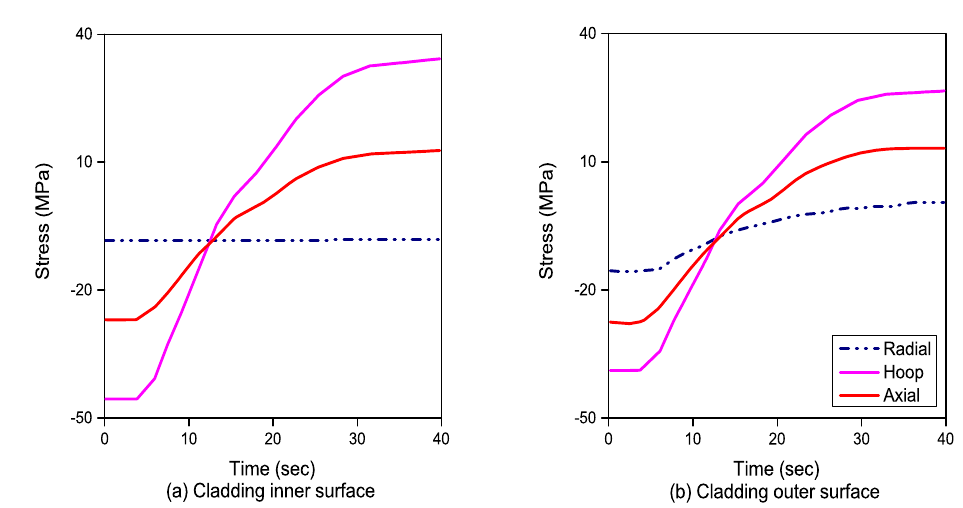
Figure 7. Pressure-induced stress